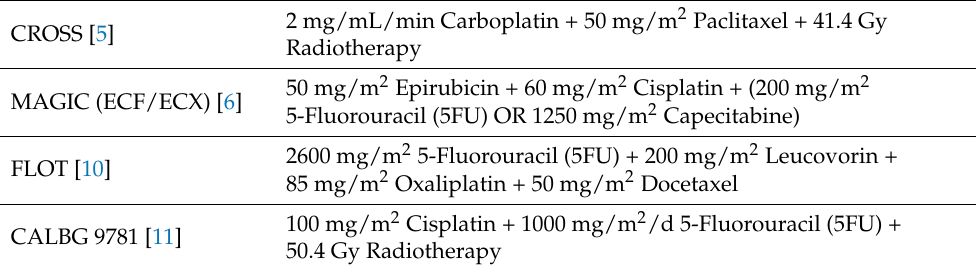
Table A10. Neoadjuvant therapy regimens.